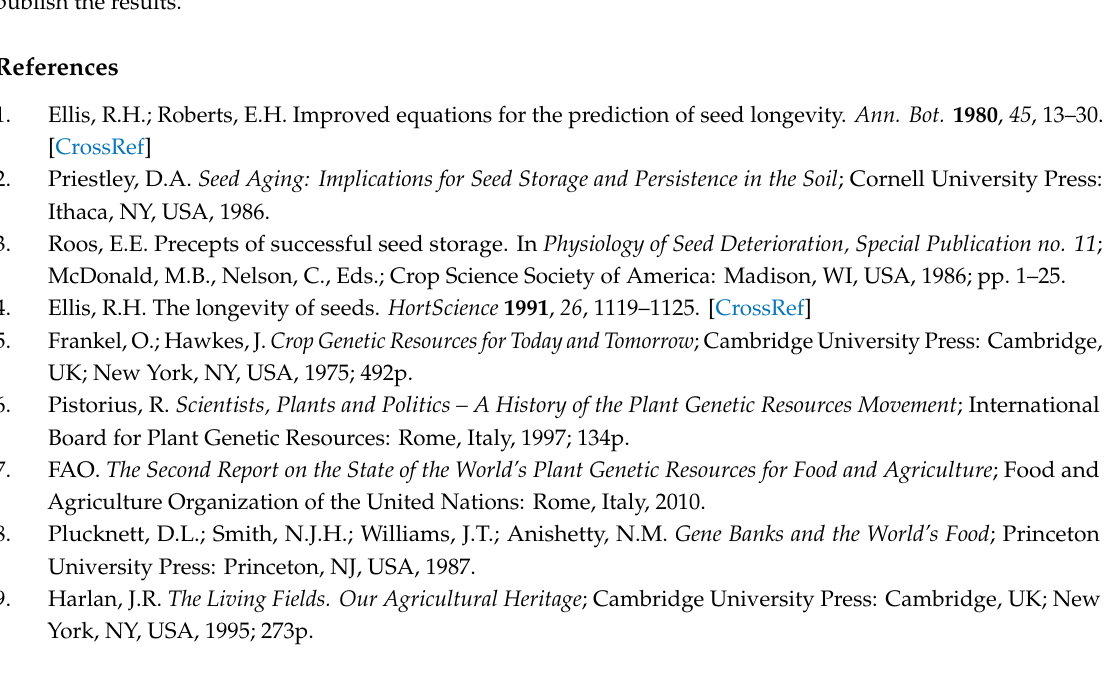
Figure S1: Illustration of germination for each seed lot included in the